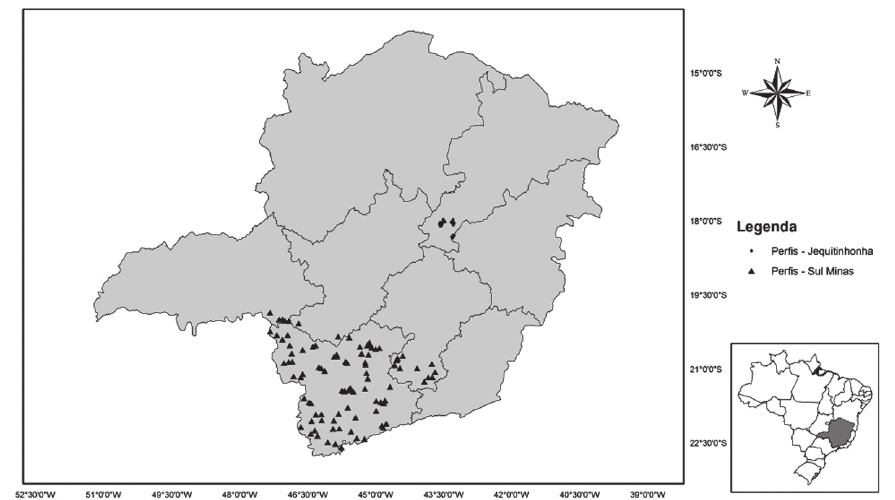
Figura 1. Distribuição geográfica dos perfis dos solos descritos e amostrados nas Regiões Sul e da Serra do Espinhaço Meridional,